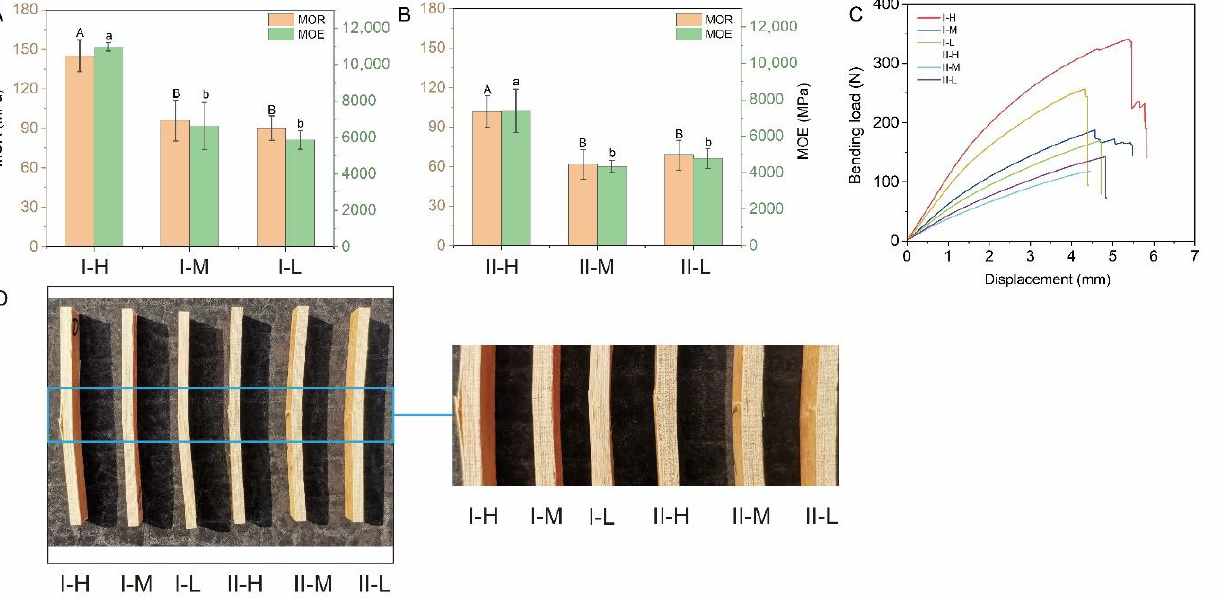
Figure 5. Bending responses of the various types of bamboo laminated composites ( BLCs): ( A ) MOR; ( B ) MOE; ( C ) bending load – displacement curves; and ( D ) observed modes of failure and their components. Upper- and lower-case letters within the columns indicate significant differences as determined by Duncan’s multiple range test ( p < 0.05).